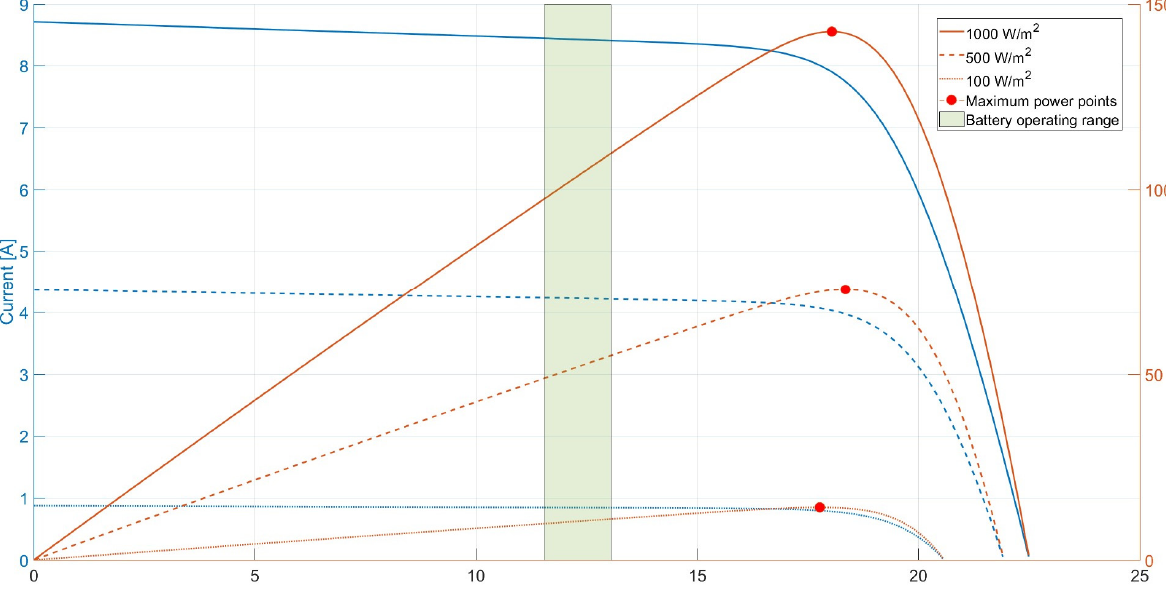
Figure 29. Estimated 5 parameter model plot of the voltage vs. current/power from the manufac- turer’s parameters.